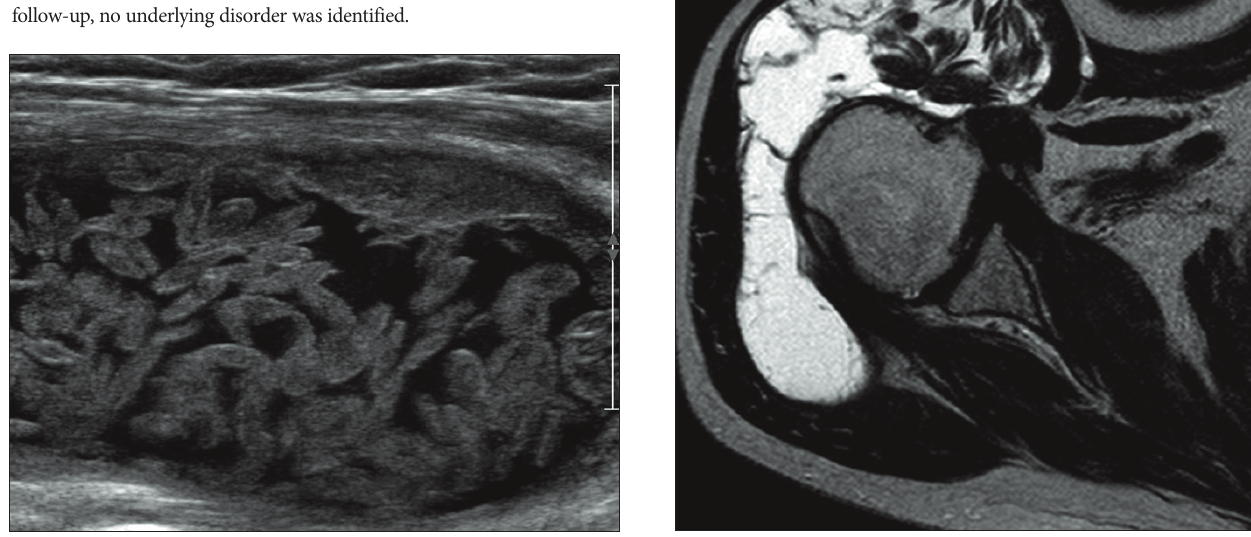
Fig. 2. Axial T2-weighted image of the right shoulder shows numerous well- delineated oval nodules with an iso-intense signal intensity relative to skeletal muscle and a large amount of bursa fluid in a markedly distended subacromial- subdeltoid